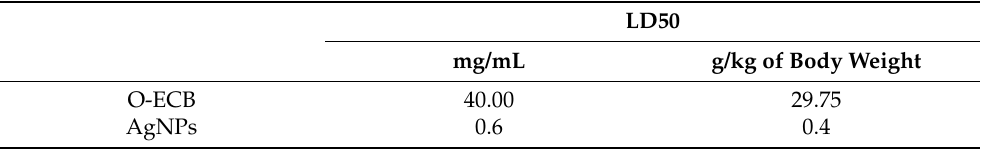
Table 9. LD50 of green-synthetized silver nanoparticles (AgNPs) and optimized ethanolic extract of Enantia chlorantha bark